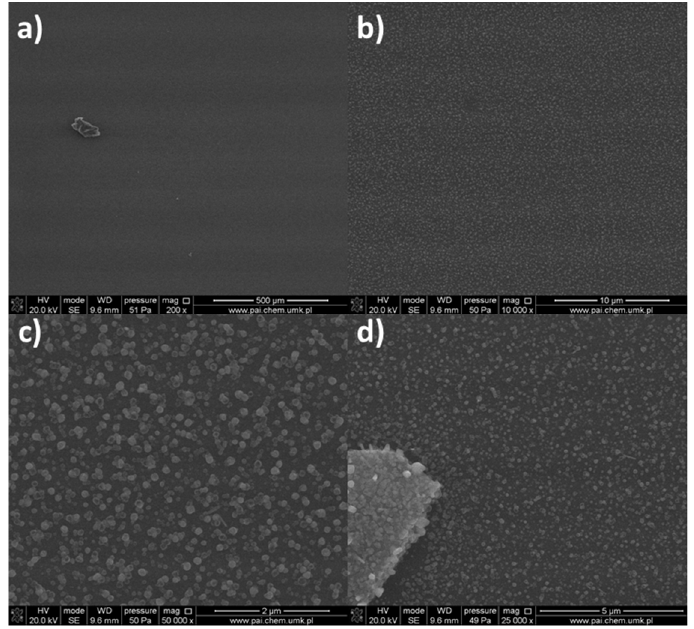
Figure 19. SEM images of [Cu 2 (EtNH 2 ) 2 (µ-O 2 CC 3 F 7 ) 4 ]/Si ( 3 ), Mag = 200× ( a ), Mag = 10,000× ( b ), Mag = 50,000× ( c ), and Mag = 25,000× ( d ), immersion time 20 s, after heating.